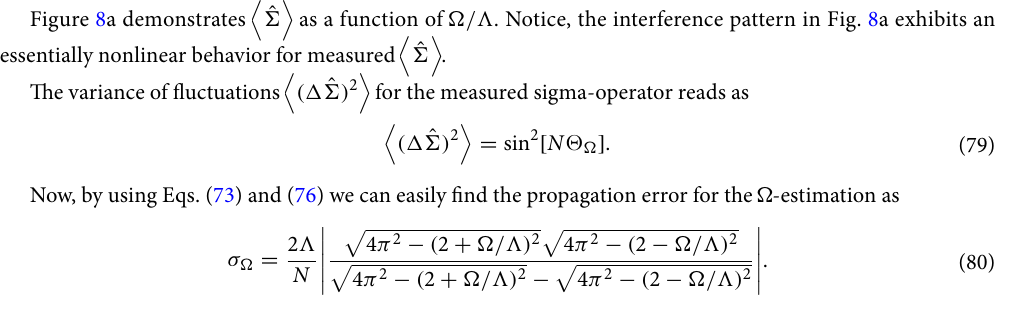
Figure 8a demonstrates essentially nonlinear behavior for measured